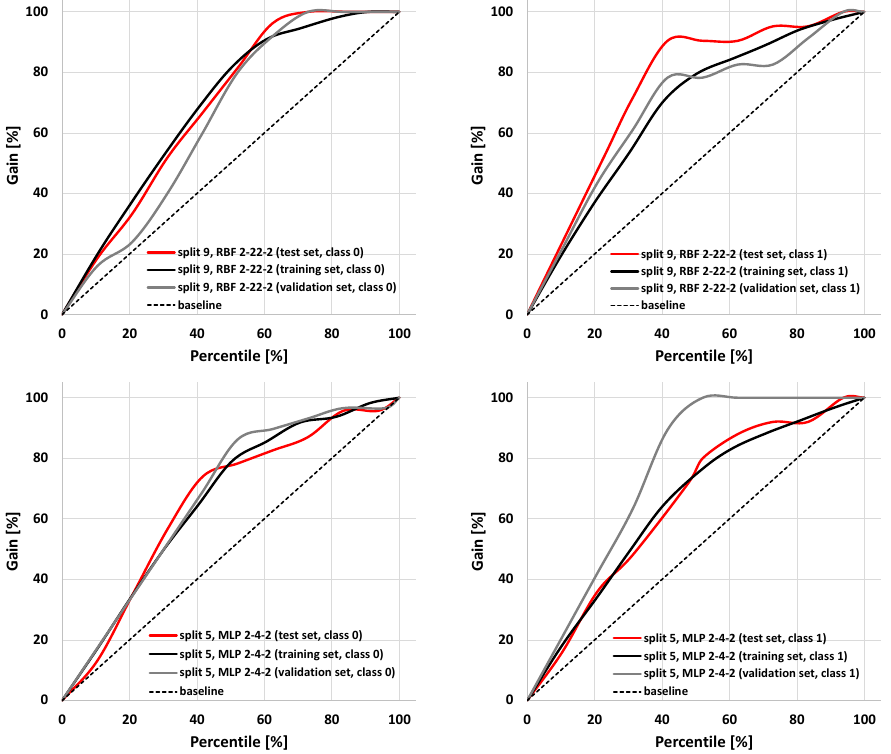
Figure 4. Cumulative gain charts for RBF 2-22-2 (split 9) and MPL 2-4-2 (split 5) models.